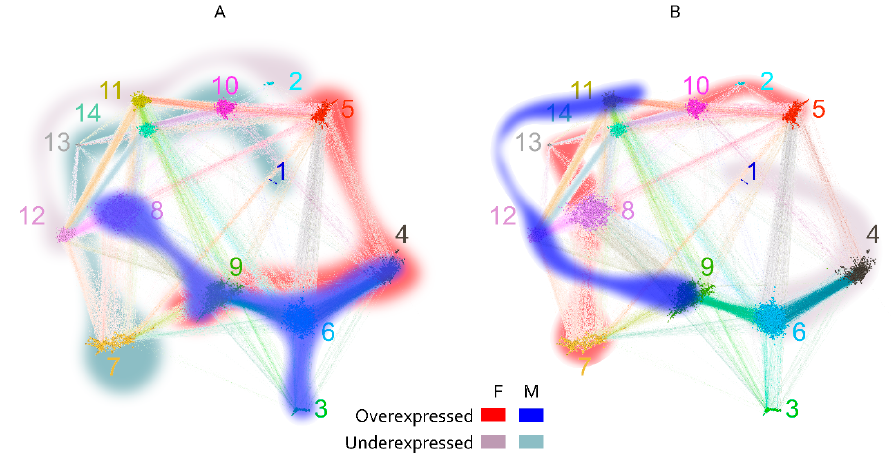
Figure 8. Map of significantly different cross-reactivity to the major clusters between blood group A ( A ) and B ( B ) antigen-carrying patients separately for men (blue scale) and women (red scale). There is a greater overlap between the sexes in the cross-reactivity spectrum in blood group A (clusters 4 and 9) than in blood group B. Some clusters have high cross-reactivity related to the presence of both A and B antigens (5, 8, and 9). Both factors define to a great extent the major patterns of cross-reactivity encoded in the graph topology. The two high-density regions containing the large cliques are also at the center of this dichotomous cross-reactivity—clusters 4, 6, and 9 for blood group A and clusters 11, 12, 13, and 14 for blood group B.